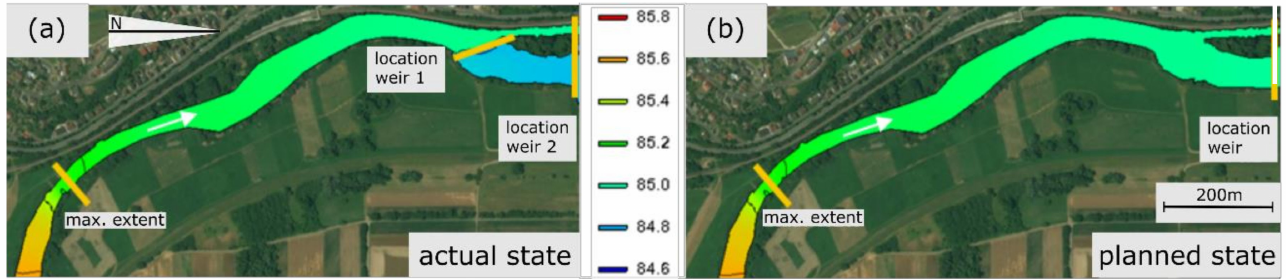
Figure 4. Water level at mean discharge in actual ( a ) and planned ( b ) conditions in masl